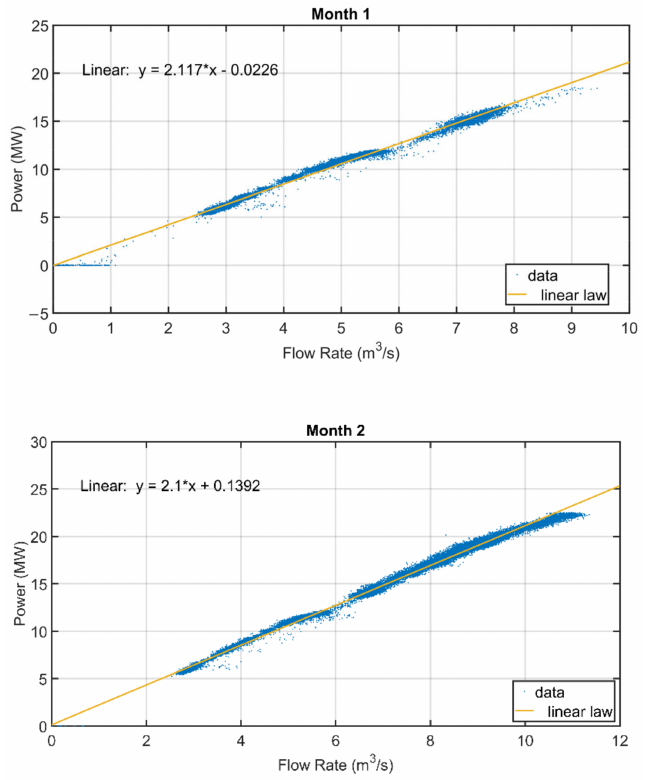
Figure 12. Measured DVs’ forecasting results: electric power production plan and downstream reservoir outlet flow rate (two months of